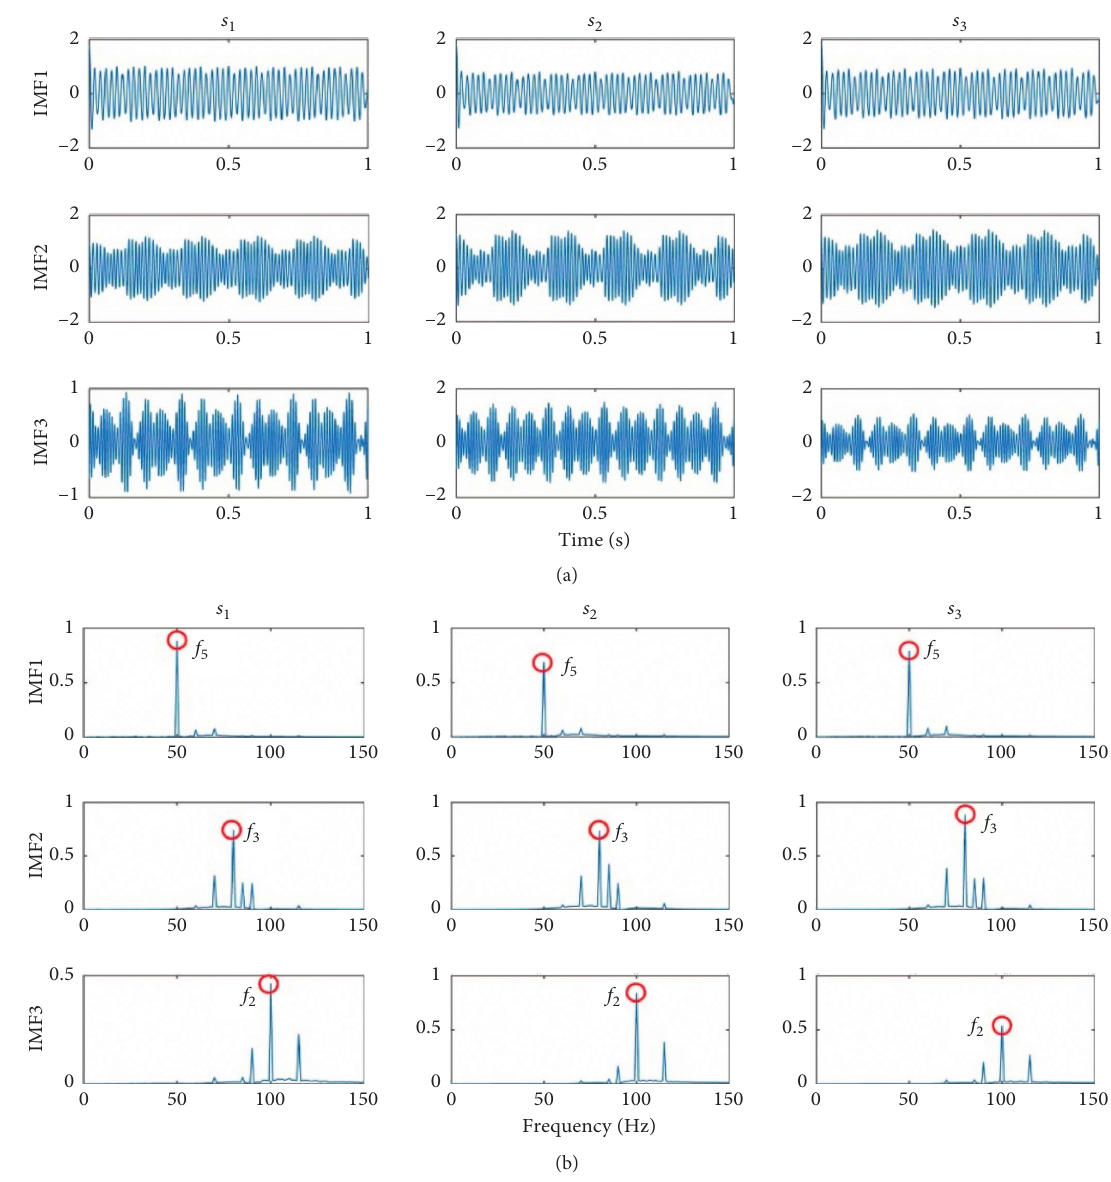
Figure 4: The decomposition results by MVMD (IMF1–IMF3). (a) Time domain. (b) Frequency domain. Table 1: The calculation time of the three algorithms.